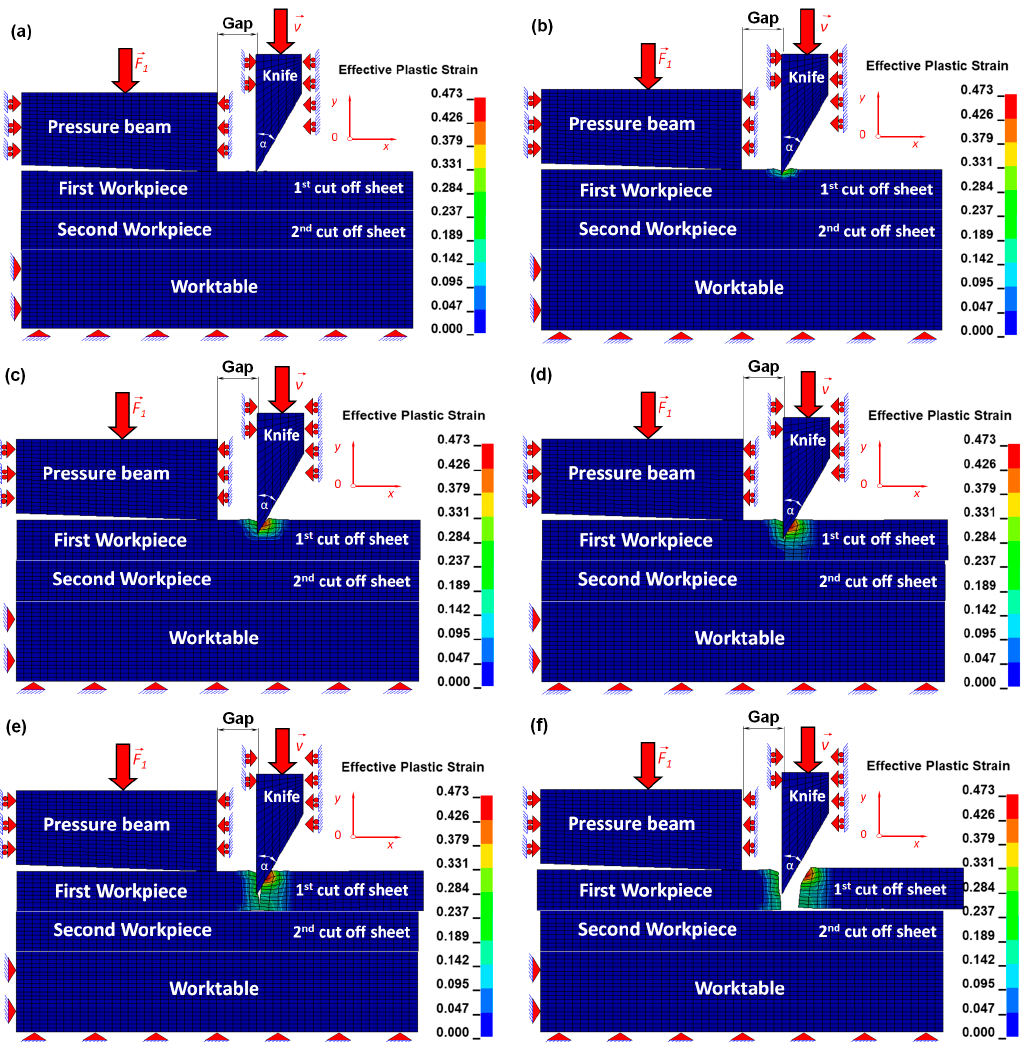
Figure 6. Effective plastic strains in the first sheet being cut for the following time instances: ( a ) t = 3 s, ( b ) t = 3.5 s, ( c ) t = 4.5 s, ( d ) t = 5 s, ( e ) t = 5.55 s, ( f ) t = 5.56 s. The effective plastic strains in the next sheet being cut are shown in the next